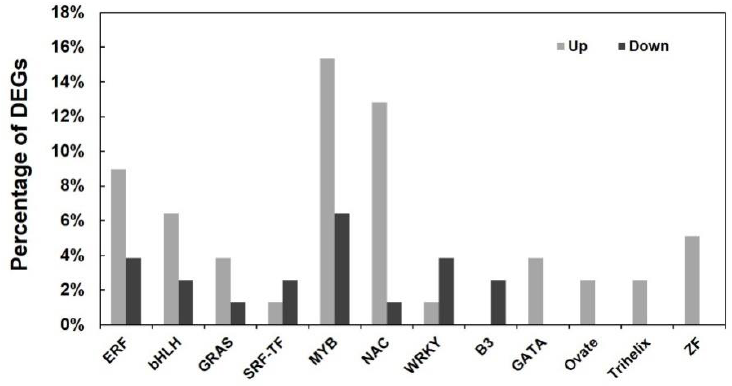
Figure 6. Up- or downregulation of DEGs encoding the members of transcription factor (TF) families in PtrARF2.1 suppressed plants.